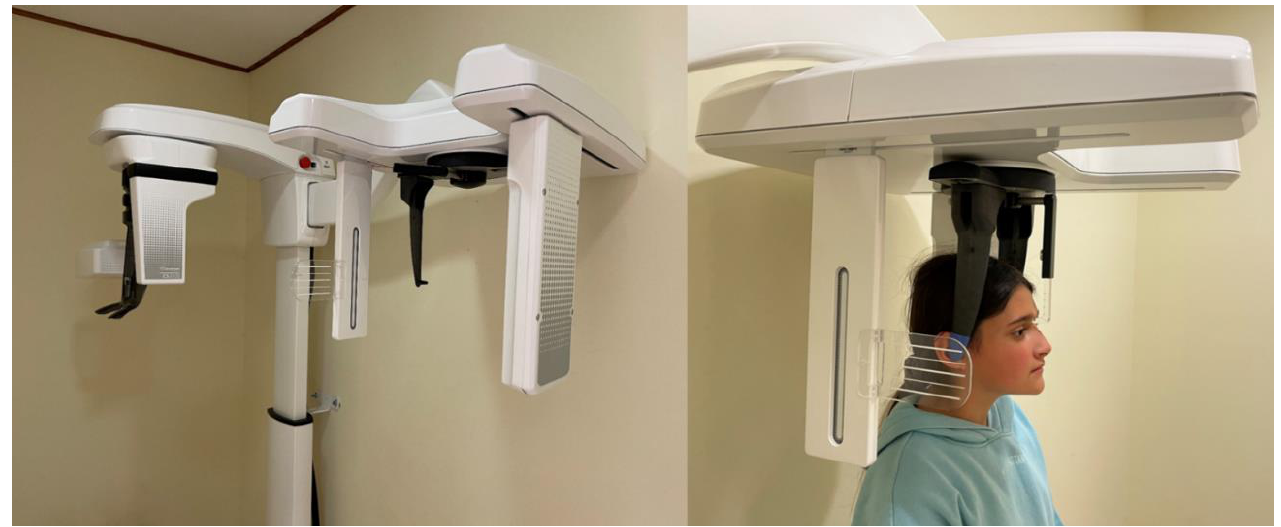
Figure 1. CS 8100 SC.